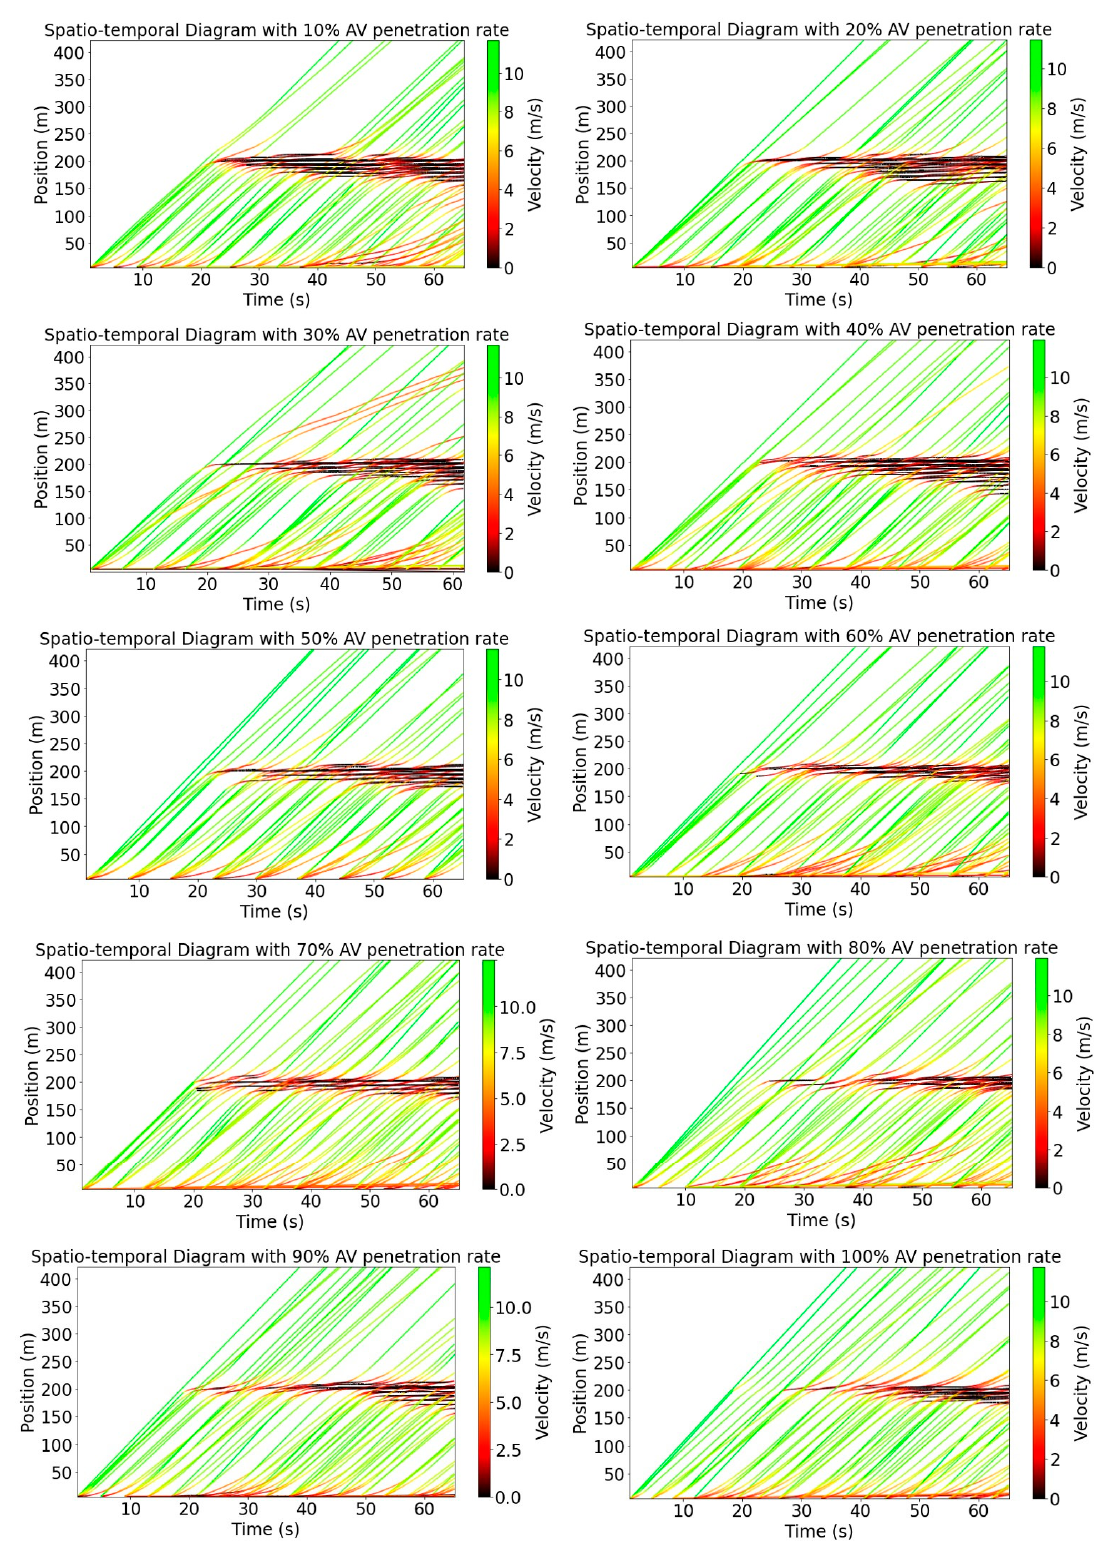
Figure 8. The spatio-temporal dynamics based on the AV penetration rate.